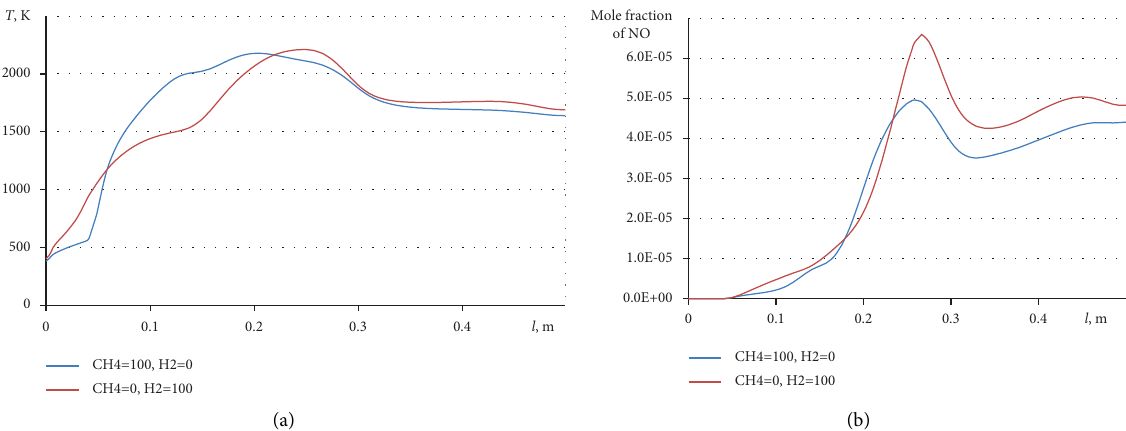
Figure 10: Dependences of temperature (a) and NO mole fraction (b) along the fame tube axis at 0 and 100% hydrogen content in the